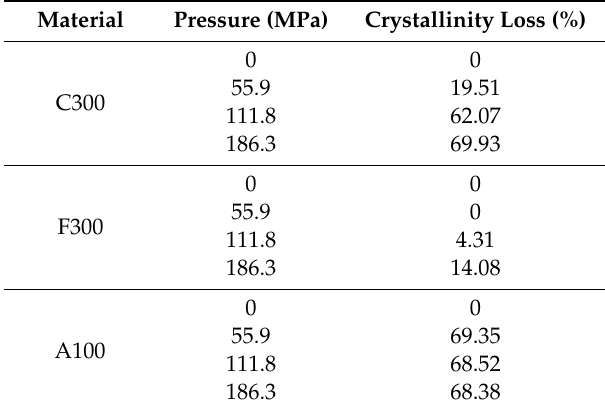
Table 2. Relative crystallinity losses associated with applied pressure (referred to the original material).